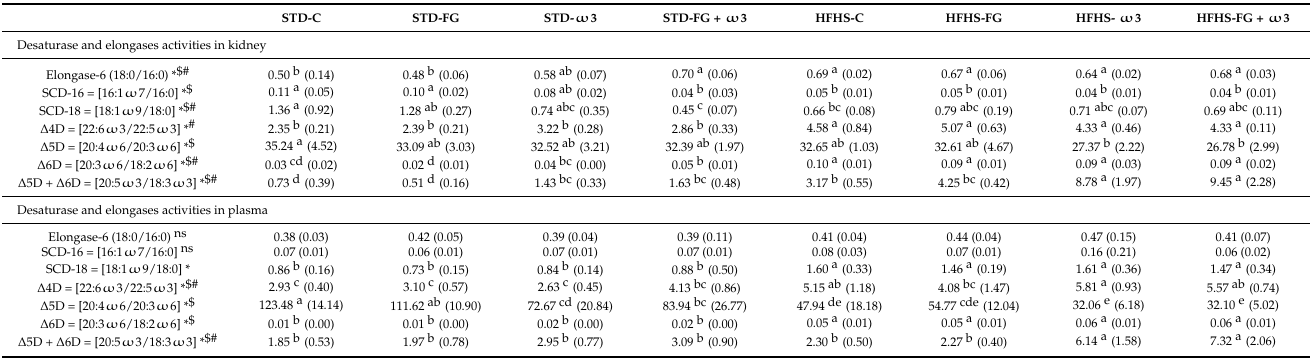
Table 4. FAD indexes and elongases activities from total fatty acid data of kidney and plasma calculated as product/precursor ratio 1